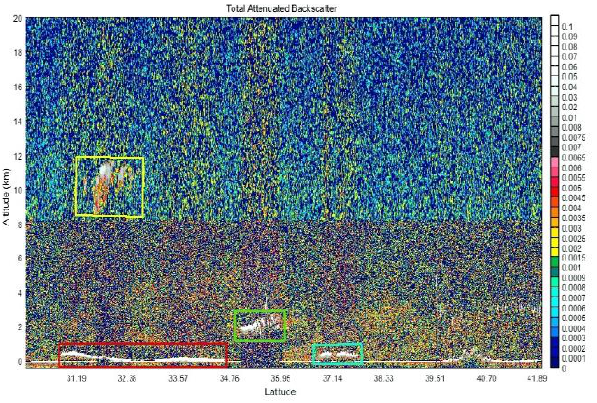
Figure 2. May 13th, 2017 CALIOP 532nm Atmospheric Attenuation Backscattering Coefficient Profile